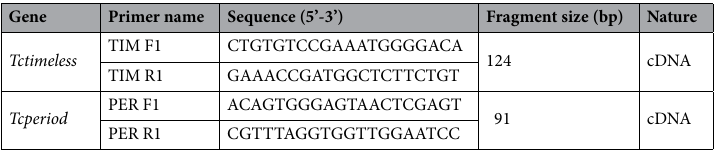
Table 1. List of primers